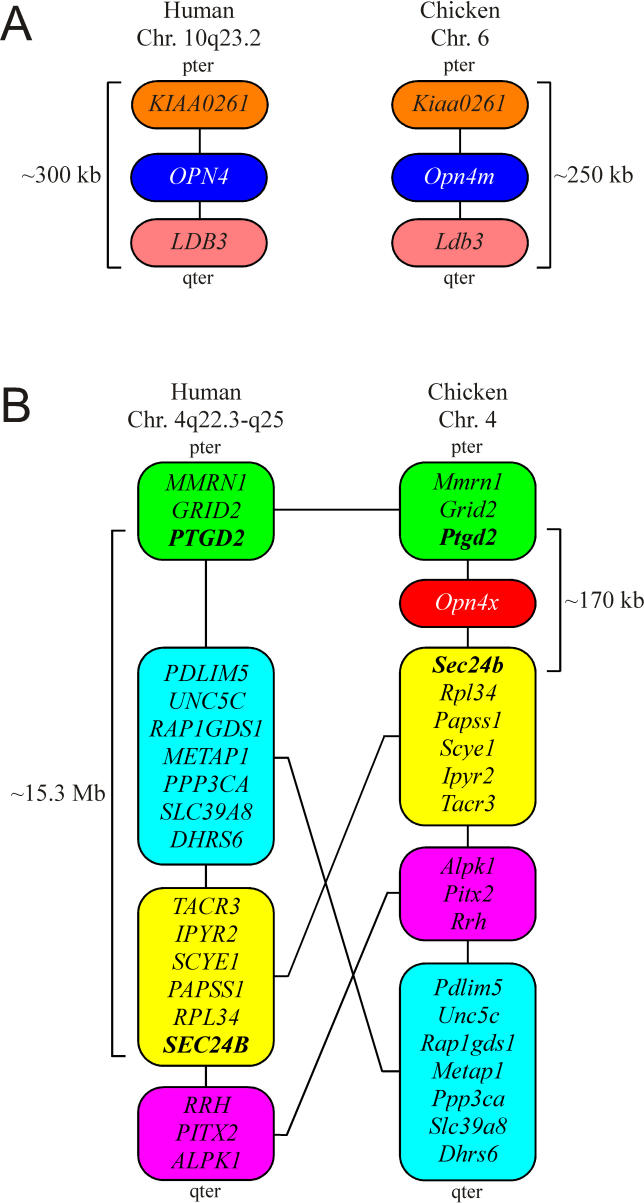
Schematic Diagrams Detailing the Chromosomal Regions Surrounding the Human and Chicken Melanopsin Loci(A) Comparison of syntenic regions encompassing the
OPN4 locus on human chromosome 10 with that of the
Opn4m locus on chicken Chromosome 4. Gene order has been conserved.
(B) Comparison of representative loci between the
PTGD2 and
SEC24B genes on human Chromosome 4q22.3-q25 (approximately 1 Mb apart) and the orthologous loci on chicken Chromosome 4. Note the intrachromosomal rearrangements and lack of an
OPN4X locus in humans.